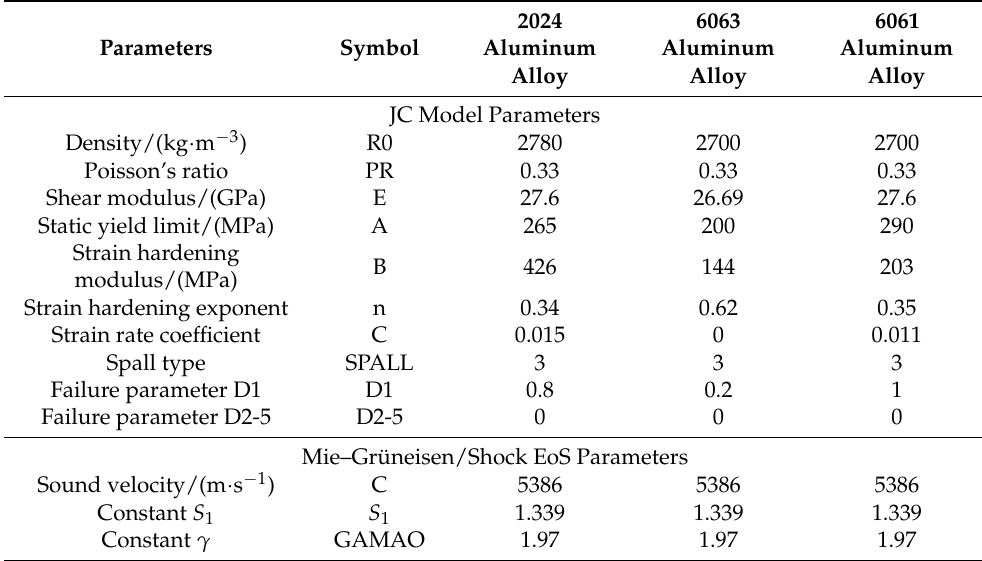
Table 1. Material parameters of simulation models